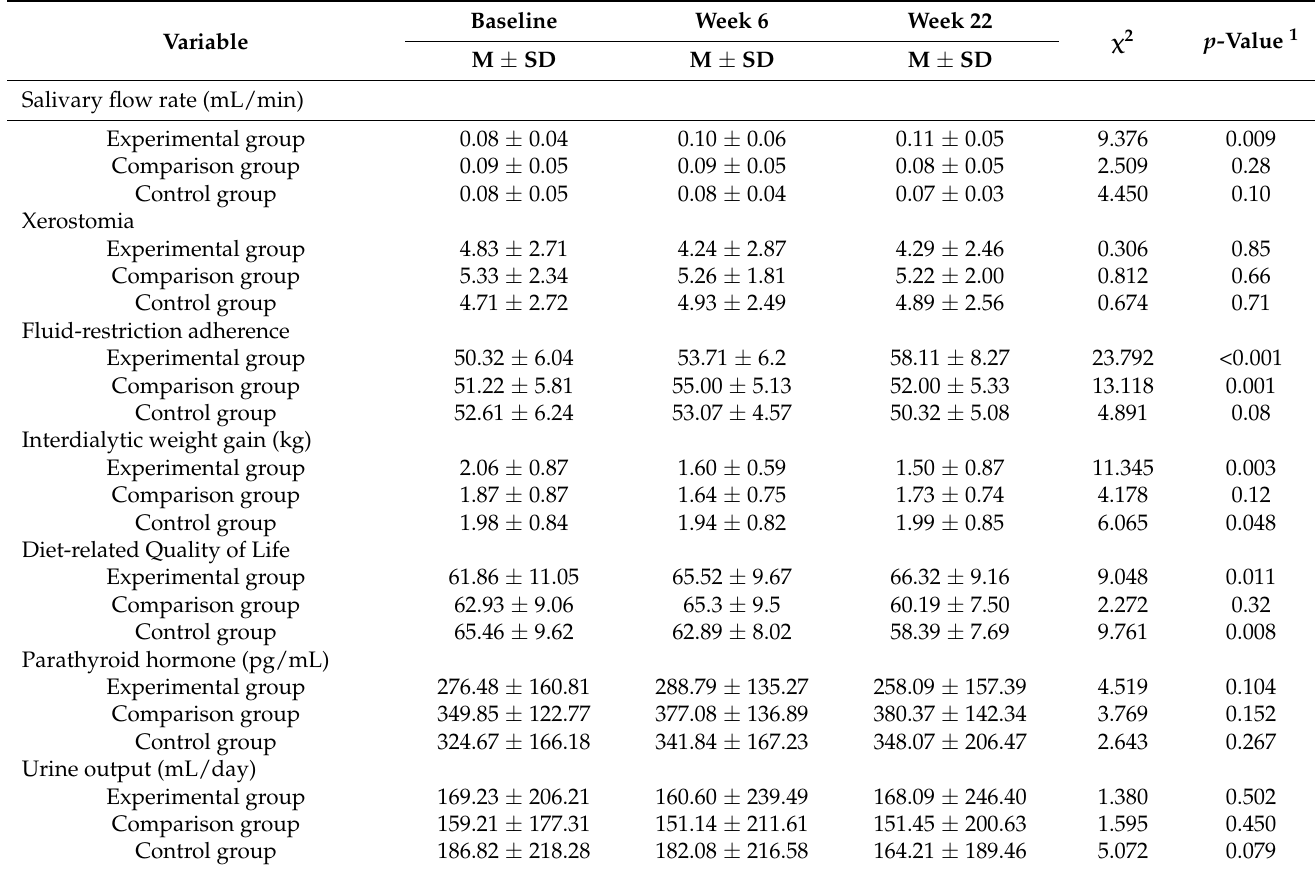
Table 2. Effects of the intervention program on study